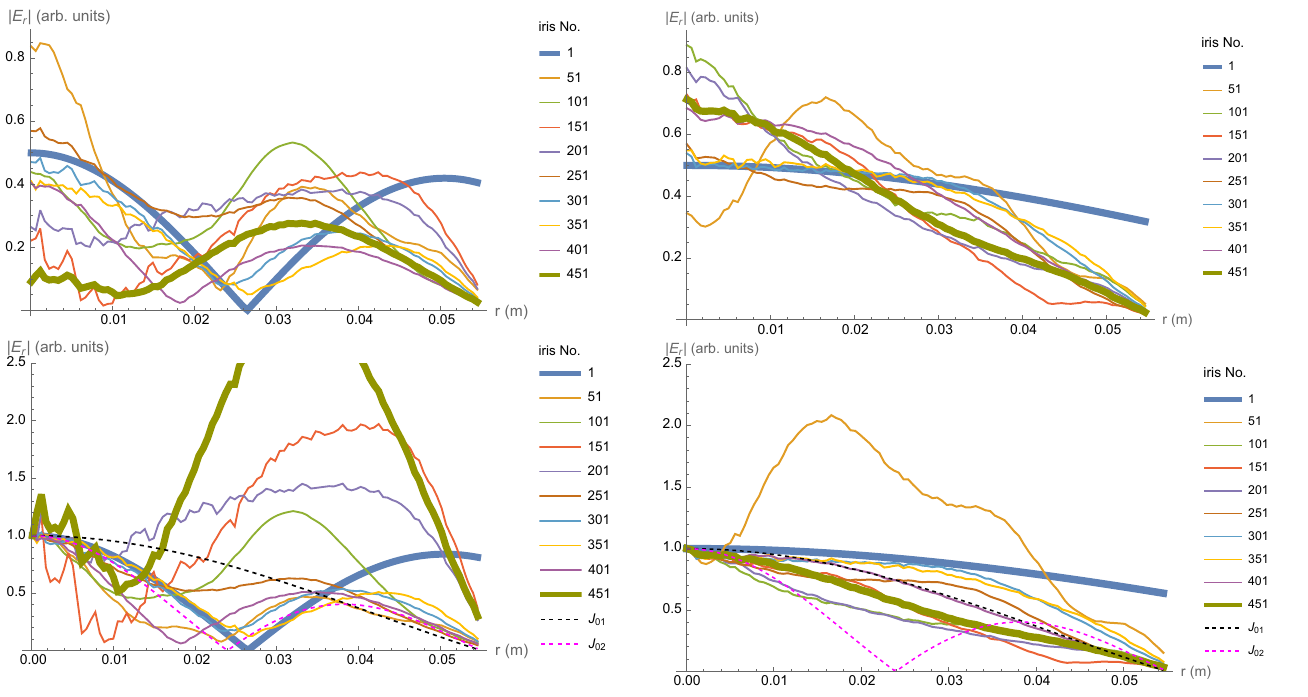
FIG. 9. Transients along the iris line (sampled at the indicated FIG. 10. Transients along the iris line (sampled at the indicated irises) for the TM 11 excitation case. The plots show the irises) for the TE 11 excitation case. The plots show the magnitude magnitude of the field component E , without (top) and with r of the field component E , without (top) and with (bottom) (bottom) normalization with respect to the amplitude on the axis r normalization with respect to the amplitude on the axis r ¼ 0 . r ¼ 0 . Heavy trace lines in the plot highlight the field profiles at Heavy trace lines in the plot highlight the field profiles at the first the first iris and last iris of the line, while dashed lines highlight iris and last iris of the line, while dashed lines highlight the first the first two eigenmodes of the iris line (denoted J 01 , J 02 ). two eigenmodes of the iris line (denoted J 01 , J 02